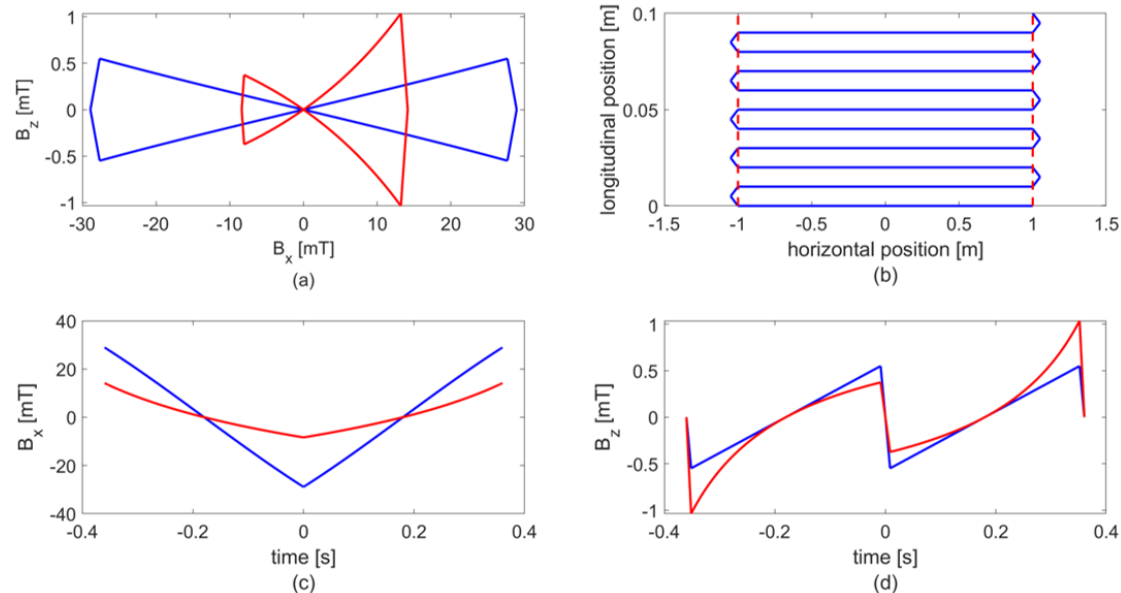
Figure 4. Raster pattern for an angle of incidence of 0 ◦ (blue) and 70 ◦ (red) in ( a ) the rest frame, the projected raster pattern on the surface of ( b ) the hide and ( c ) B x and ( d ) B z vs. time. In ( b ), the raster pattern projected on the surface of the hide is the same for all angles of incidence. The dashed red lines represent the edge of the hide to highlight the overshoot